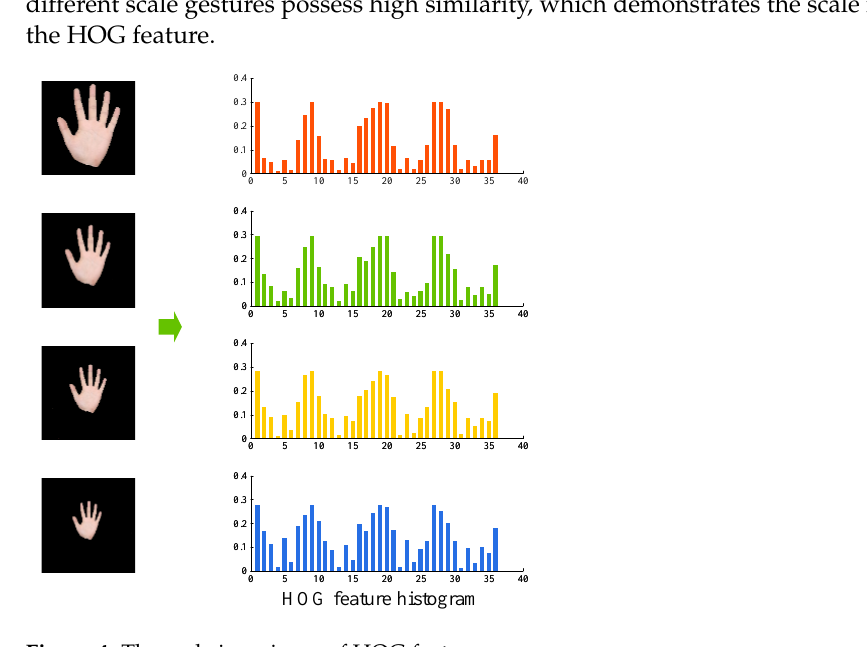
Figure 4. The scale invariance of HOG